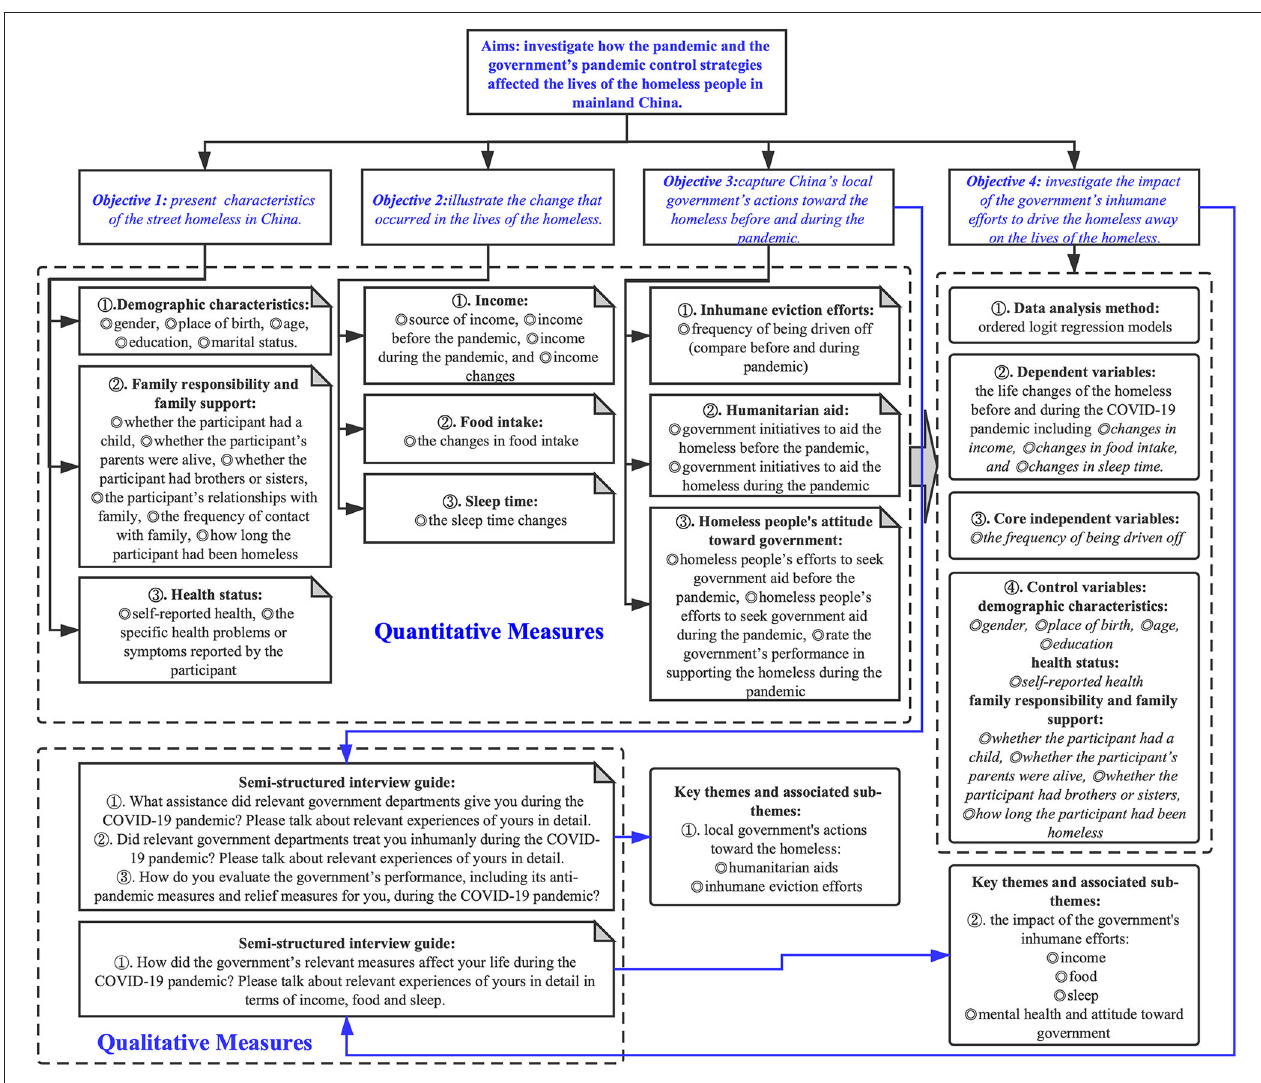
FIGURE 1 | Flowchart of the research